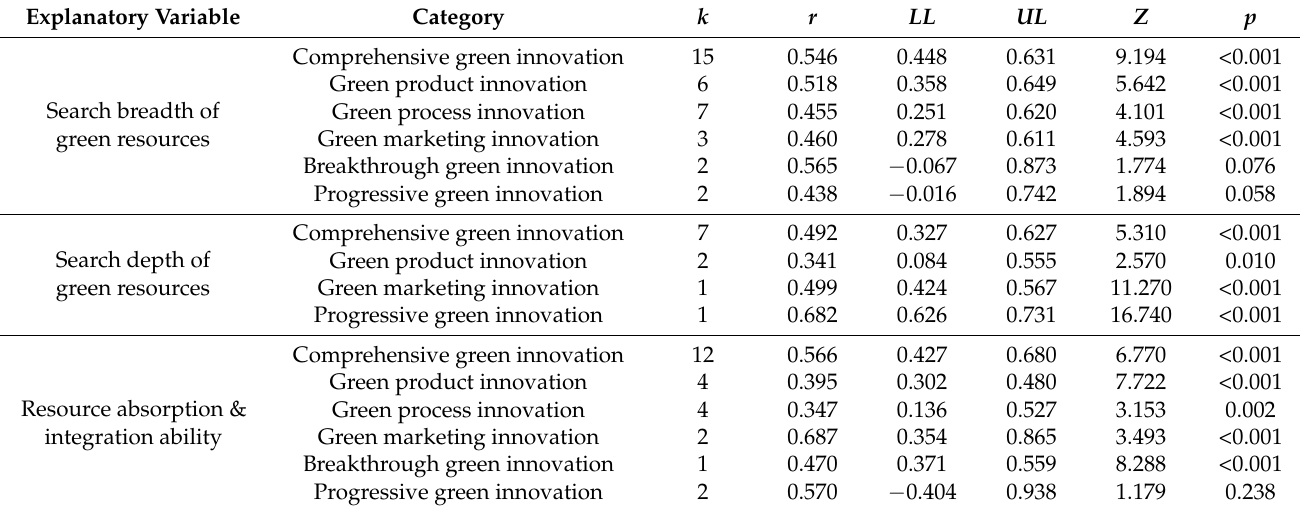
Table 5. Analysis Results of the Moderating Effect of Green Innovation